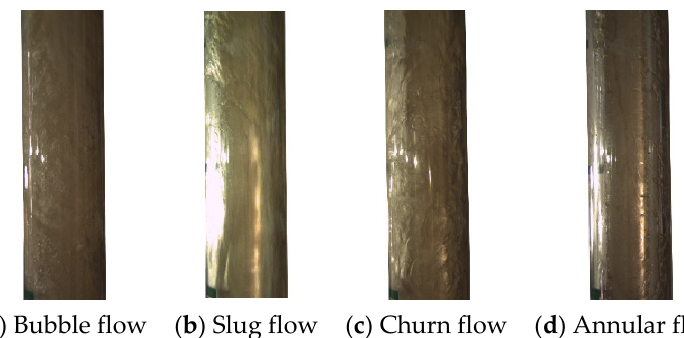
Figure 5. Flow pattern observed in the experiment at an inclination angle of 90 ◦